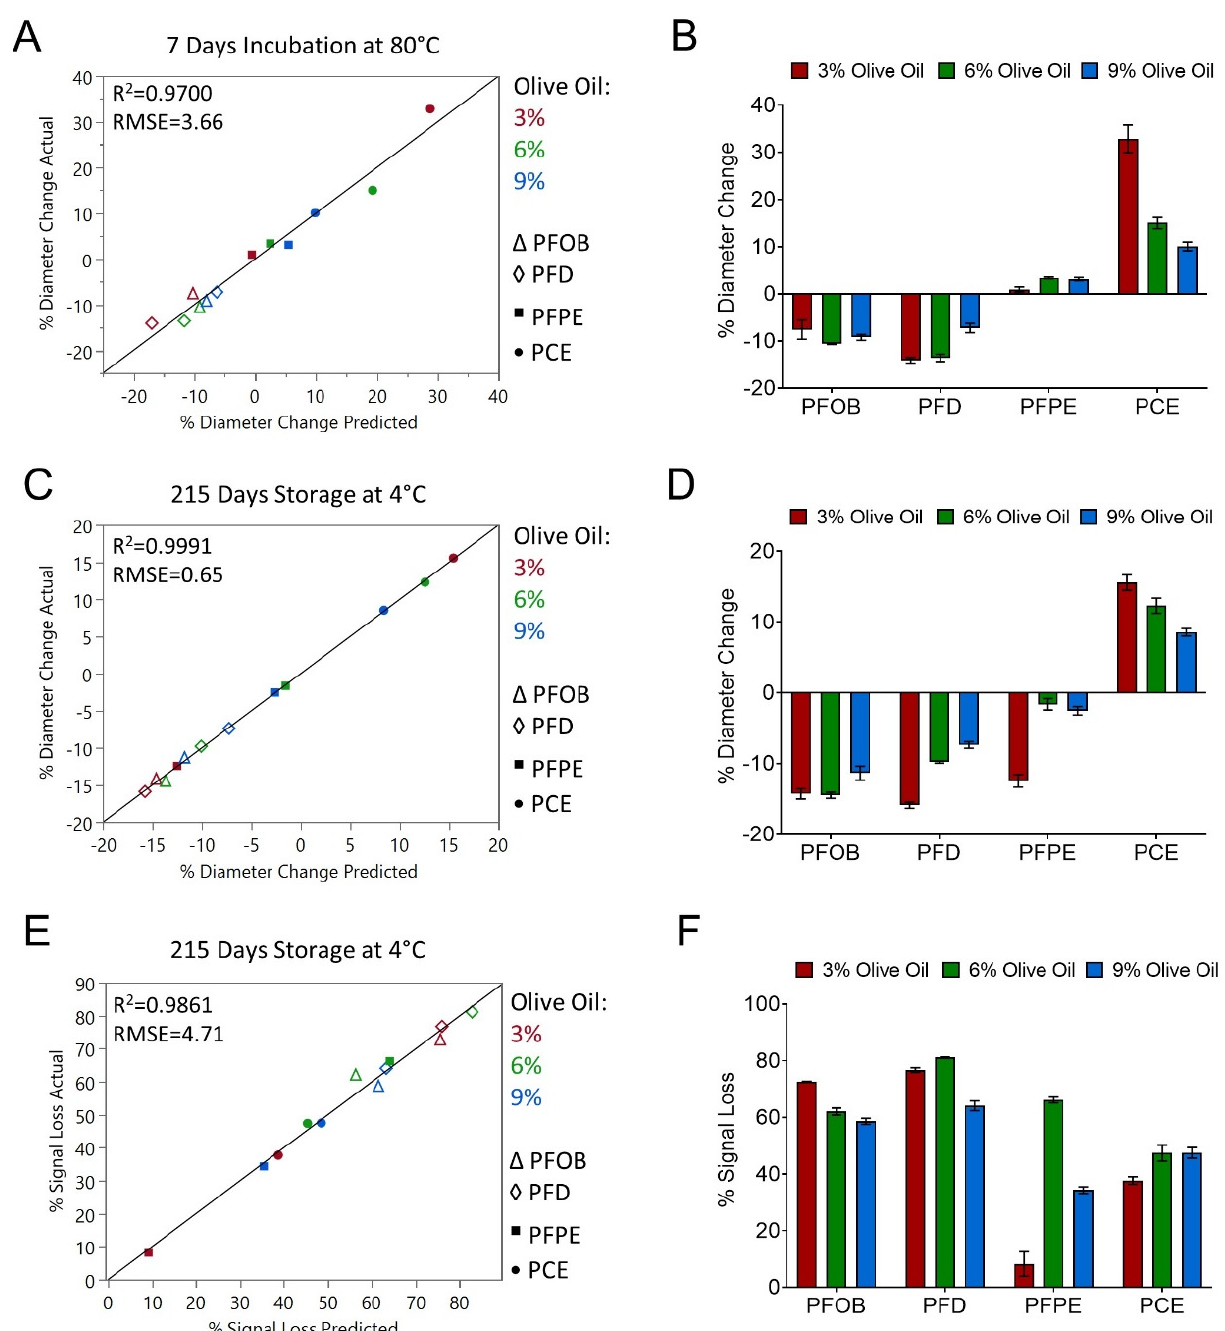
Figure 4. MLR models were developed to predict ( A , B ) nanoemulsion percent diameter change after 7 days incubation at 80 °C, ( C , D ) nanoemulsion percent diameter change after 215 days storage at 4 °C, and ( E , F ) nanoemulsion percent fluorescence signal loss after 215 days storage at 4 °C.